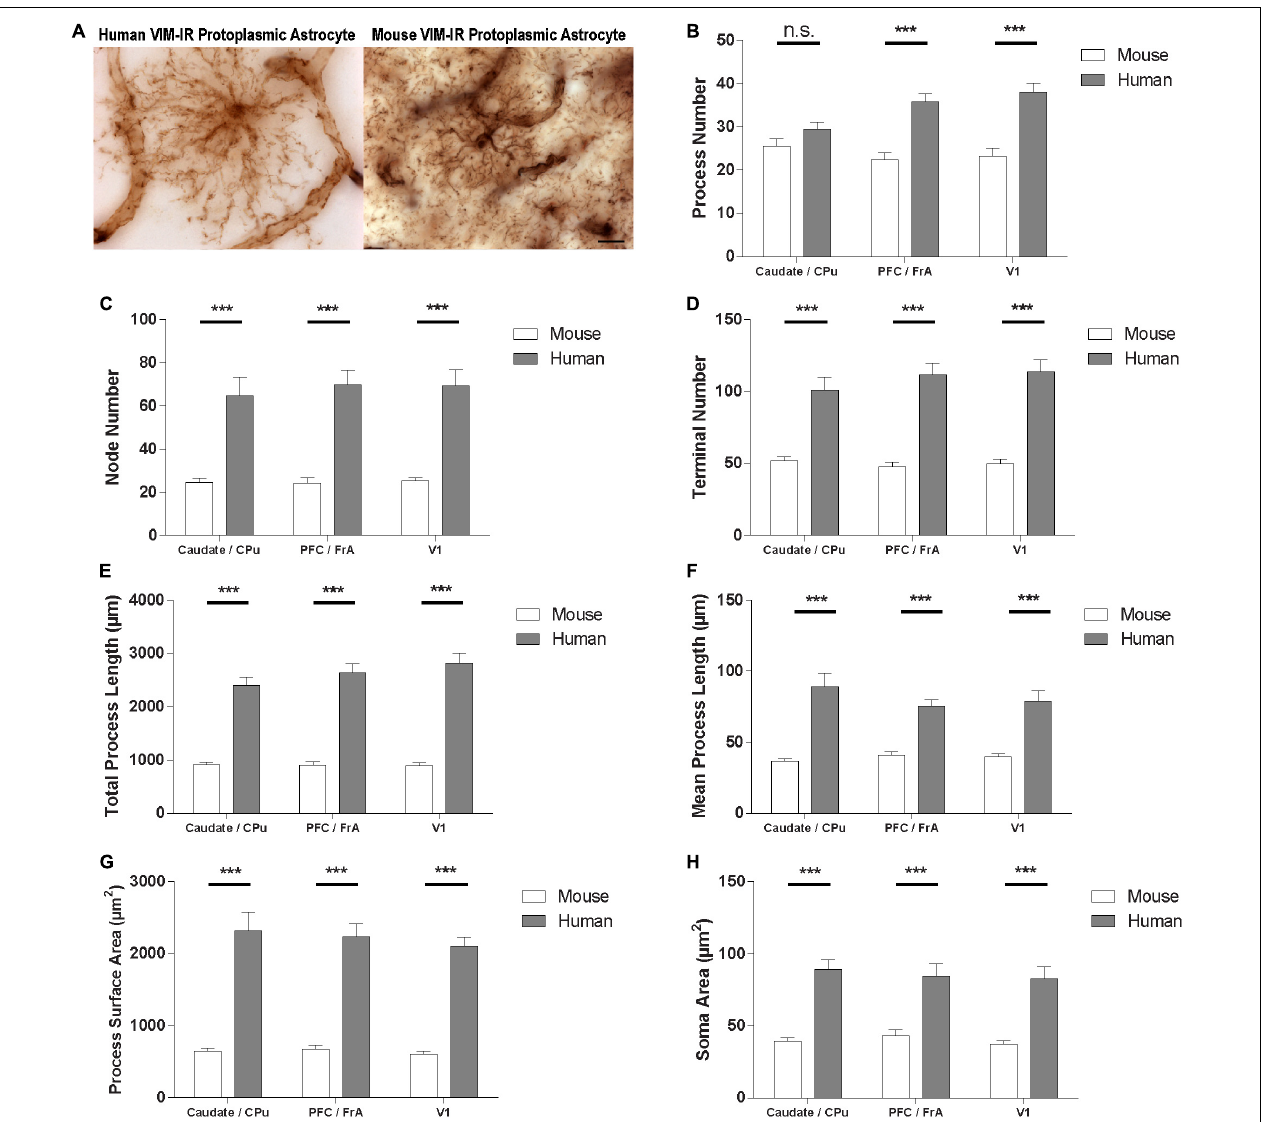
FIGURE 8 | VIM-IR astrocyte morphometry reveals considerably more complex cerebral astrocytes in humans than in mouse. (A) Representative VIM-IR astrocytes from the human (left) and the mouse (right) primary visual cortex. (B–H) Human VIM-IR astrocytes were distinguishable from mouse VIM-IR astrocytes for all regions and BSA measures, except for process number in the caudate nucleus. Scale bars = 10 µ m. n.s. p > 0.05, *** p ≤ 0.001 ( n = 5; Mann–Whitney U